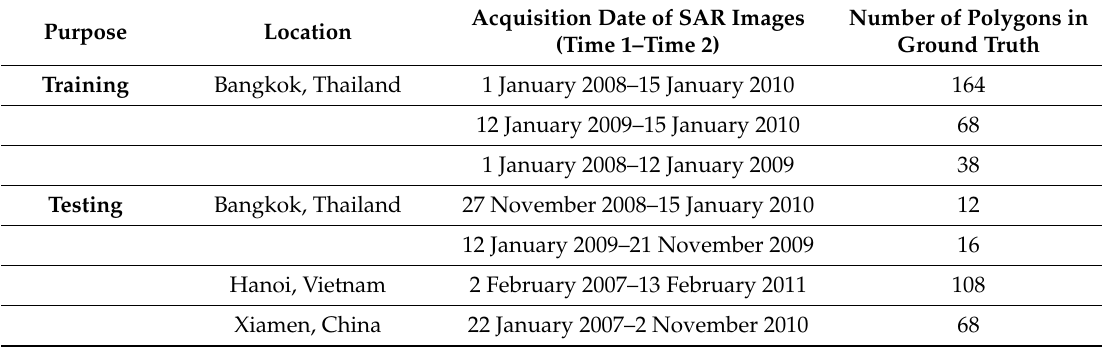
Table 1. Acquisition information of dataset. SAR—synthetic-aperture